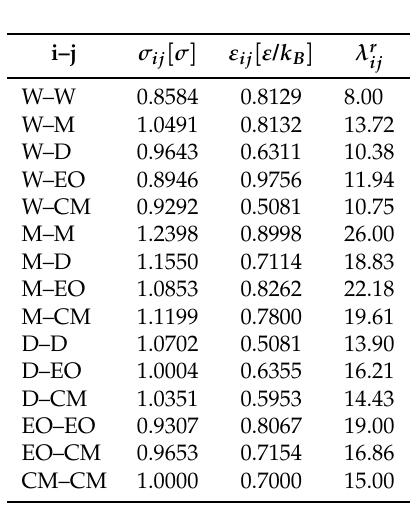
= 6 for all cases. The length and the ij